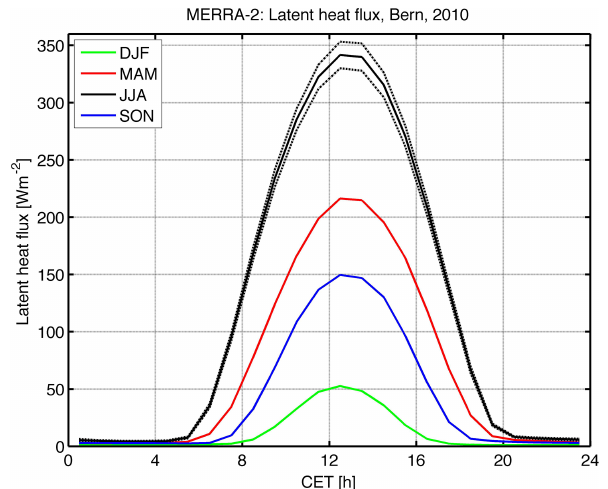
Figure 6. Diurnal cycle of latent heat flux near Bern for different seasons as derived from MERRA-2 reanalysis data. The error of the mean (for hourly averages) is shown for the summer season (JJA) by the dashed black